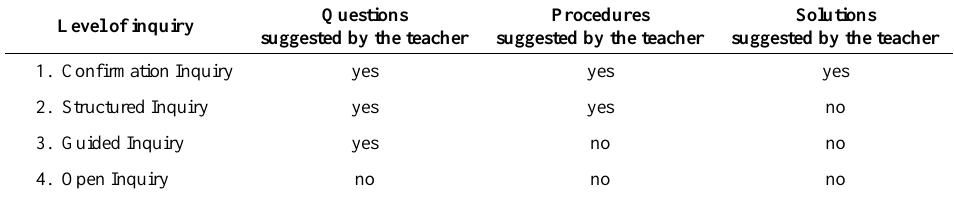
Table 1. Levels of inquiry